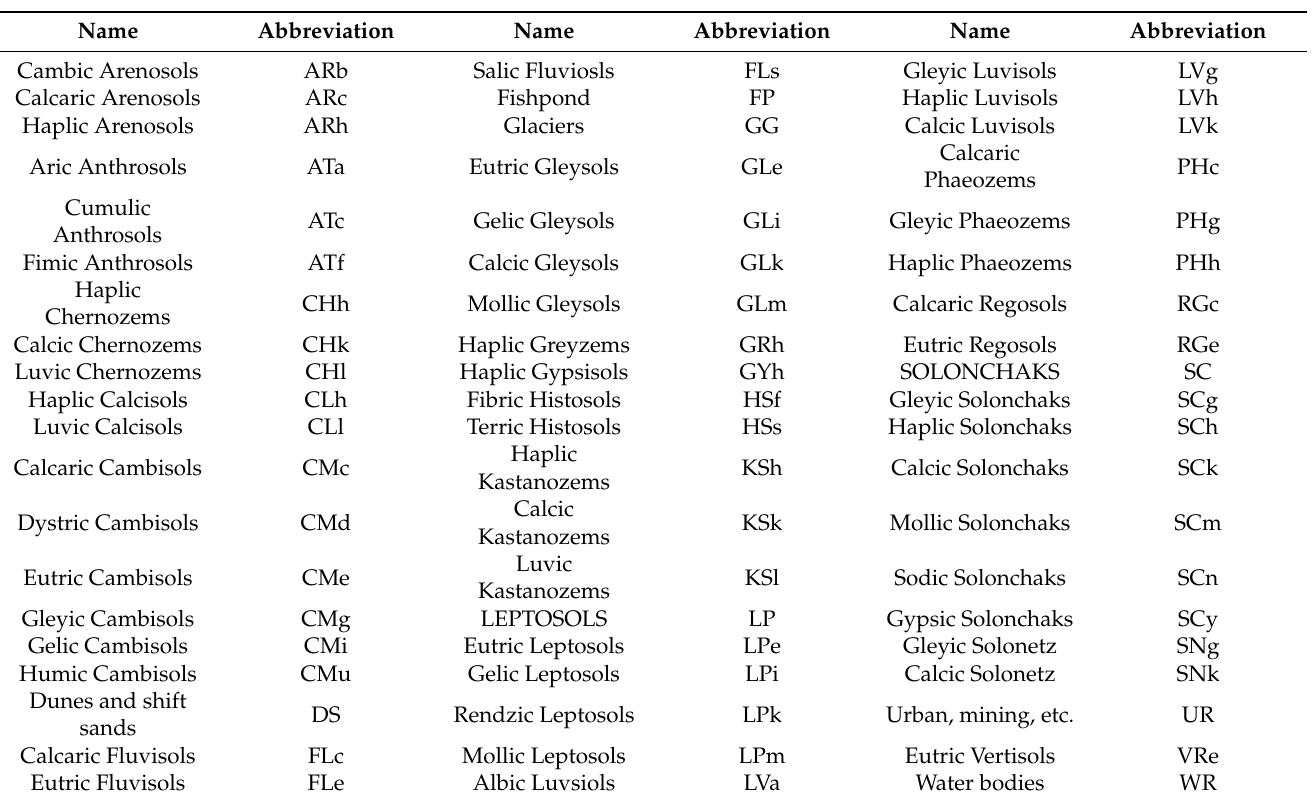
Table 2. Names and abbreviations of soil